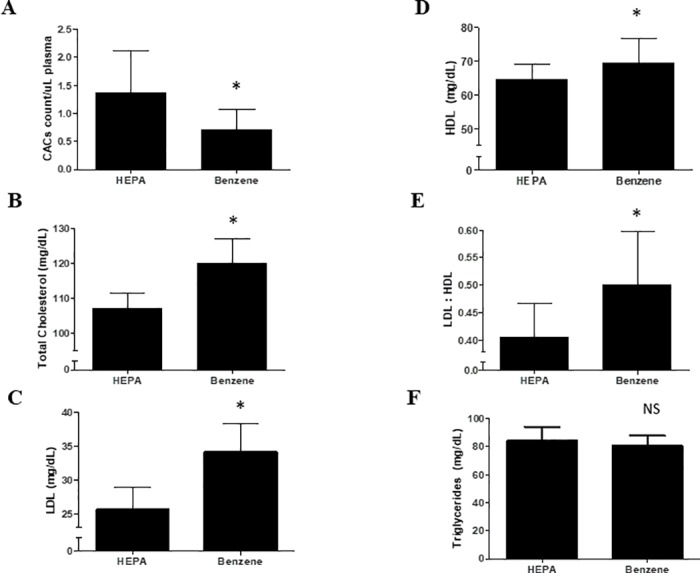
Volatile benzene exposure decreases murine CACs and increases lipoprotein levels.(A) Flk-1+/Sca-1+ cells were measured in C57Bl/6 mice after 6 weeks of exposure to volatile benzene (50ppm, 6h/d) and filtered air. The benzene exposed animals showed an approximate 48% decrease in these cells after six weeks of benzene exposure. Levels of total plasma cholesterol (B), LDL (C), HDL (D), triglycerides (F) were also quantified in the exposed mice. An LDL:HDL ratio was also calculated (E). All plasma variables except triglycerides were elevated in benzene-exposed mice compared with the filtered air exposed controls. n = 22-39/treatment group; *: p<0.05.